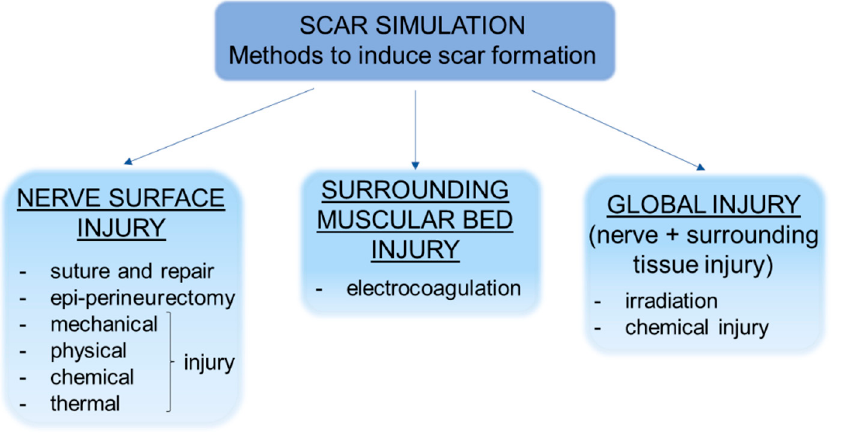
Figure 1. Representative scheme showing the different strategies to simulate scar formation in preclinical models.